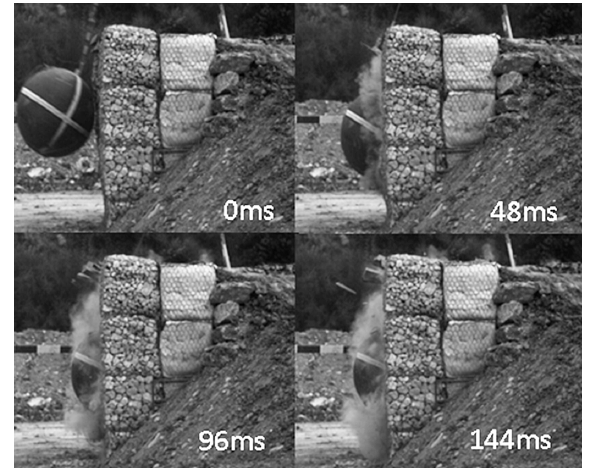
Figure 14. High-speed camera images during the fourth-impact test (2200kJ).